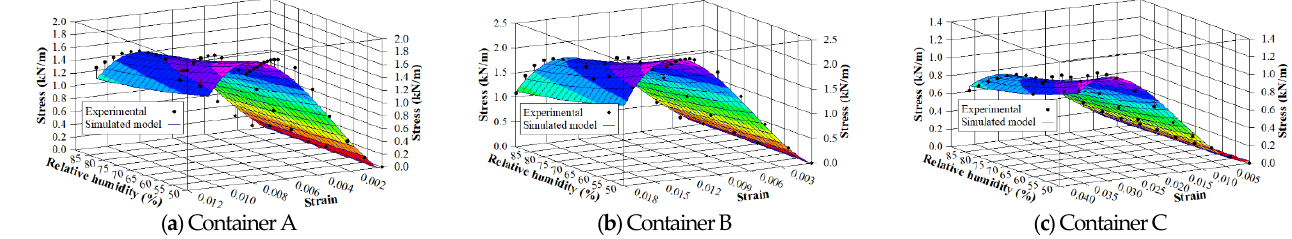
Figure 4. Response surface analysis results for the SS behavior of the target shipping containers. Table 5. SS behavior modeling results for the target shipping